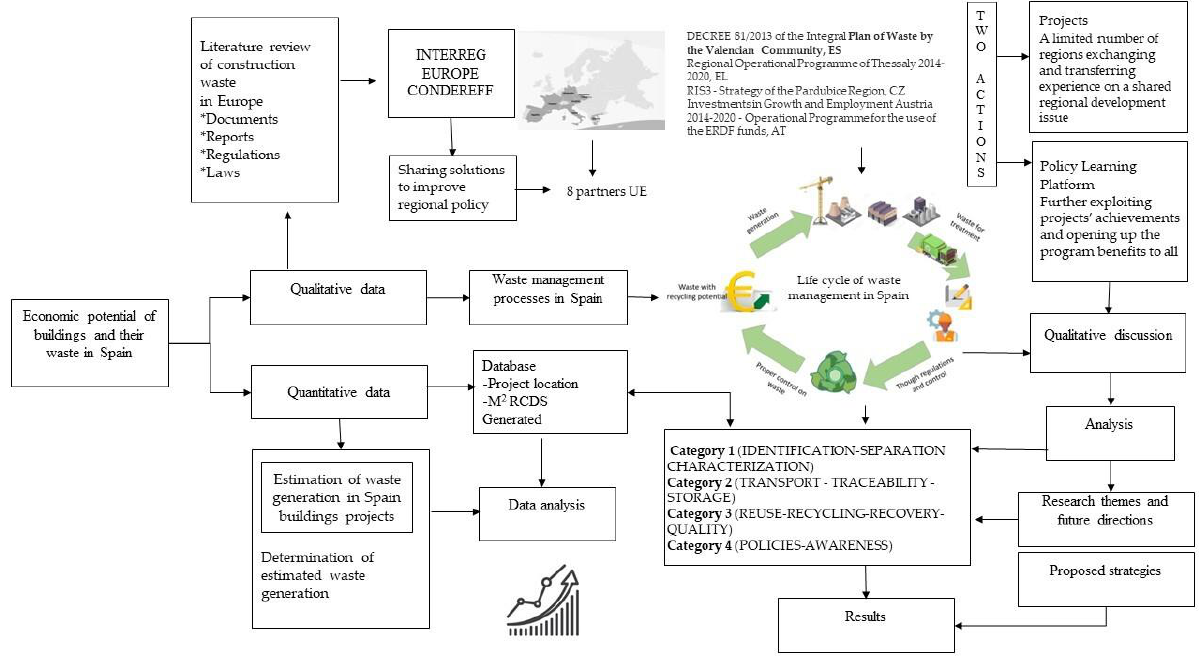
Figure 2. Methodological process of economic potential in Spain from waste production. Own elab- oration.